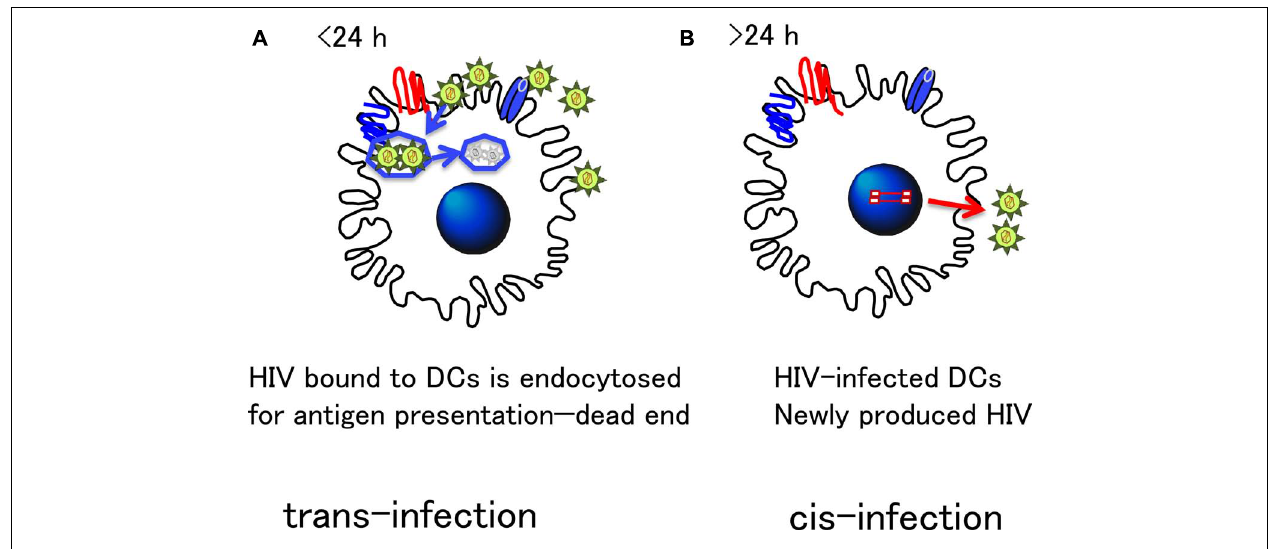
FIGURE 3 | Distinct HIV transmission mode by DCs: Cis- and Trans- infection. There are two modes of transmission of HIV from DC to T cells. (A) Trans- infection: DCs express various receptors to bind foreign antigens, which is important to efficiently endocytose and process for antigen presentation. Such machinery is highlighted for HIV transfer in trans in in vitro experiments. However, because endocytosed antigens are quickly degraded within 24 h (Turville etal., 2004), infectious HIV particles may not retain their infectivity for a long time.Thus, the physiological relevancy of trans - infection